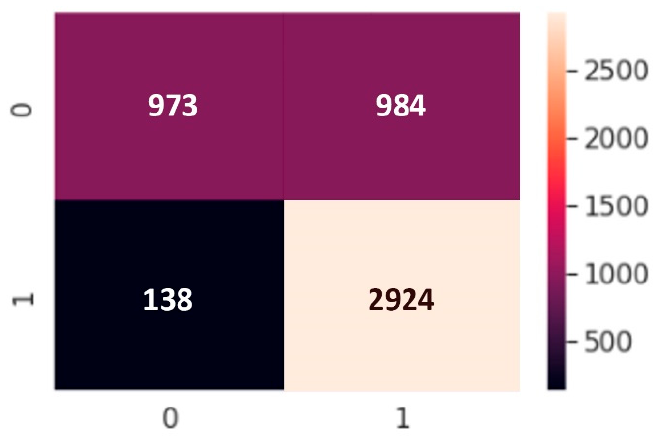
Figure 12. Confusion matrix of CNN model.